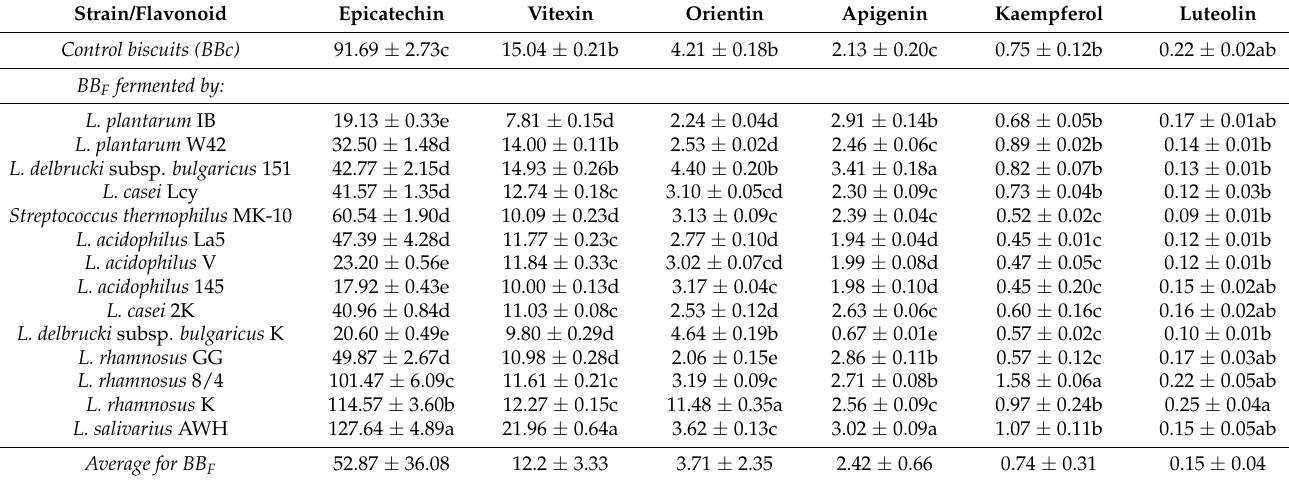
Table 4. The content of flavonoids ( µ g/g DM) in buckwheat biscuits prepared from not fermented (BBc) and fermented flours (BB F ) by selected lactic acid bacteria. Data are expressed as mean ± standard deviation ( n = 3). Means in each column followed by different letters are significantly different ( p < 0.05) based on the one-way analysis of variance (ANOVA).